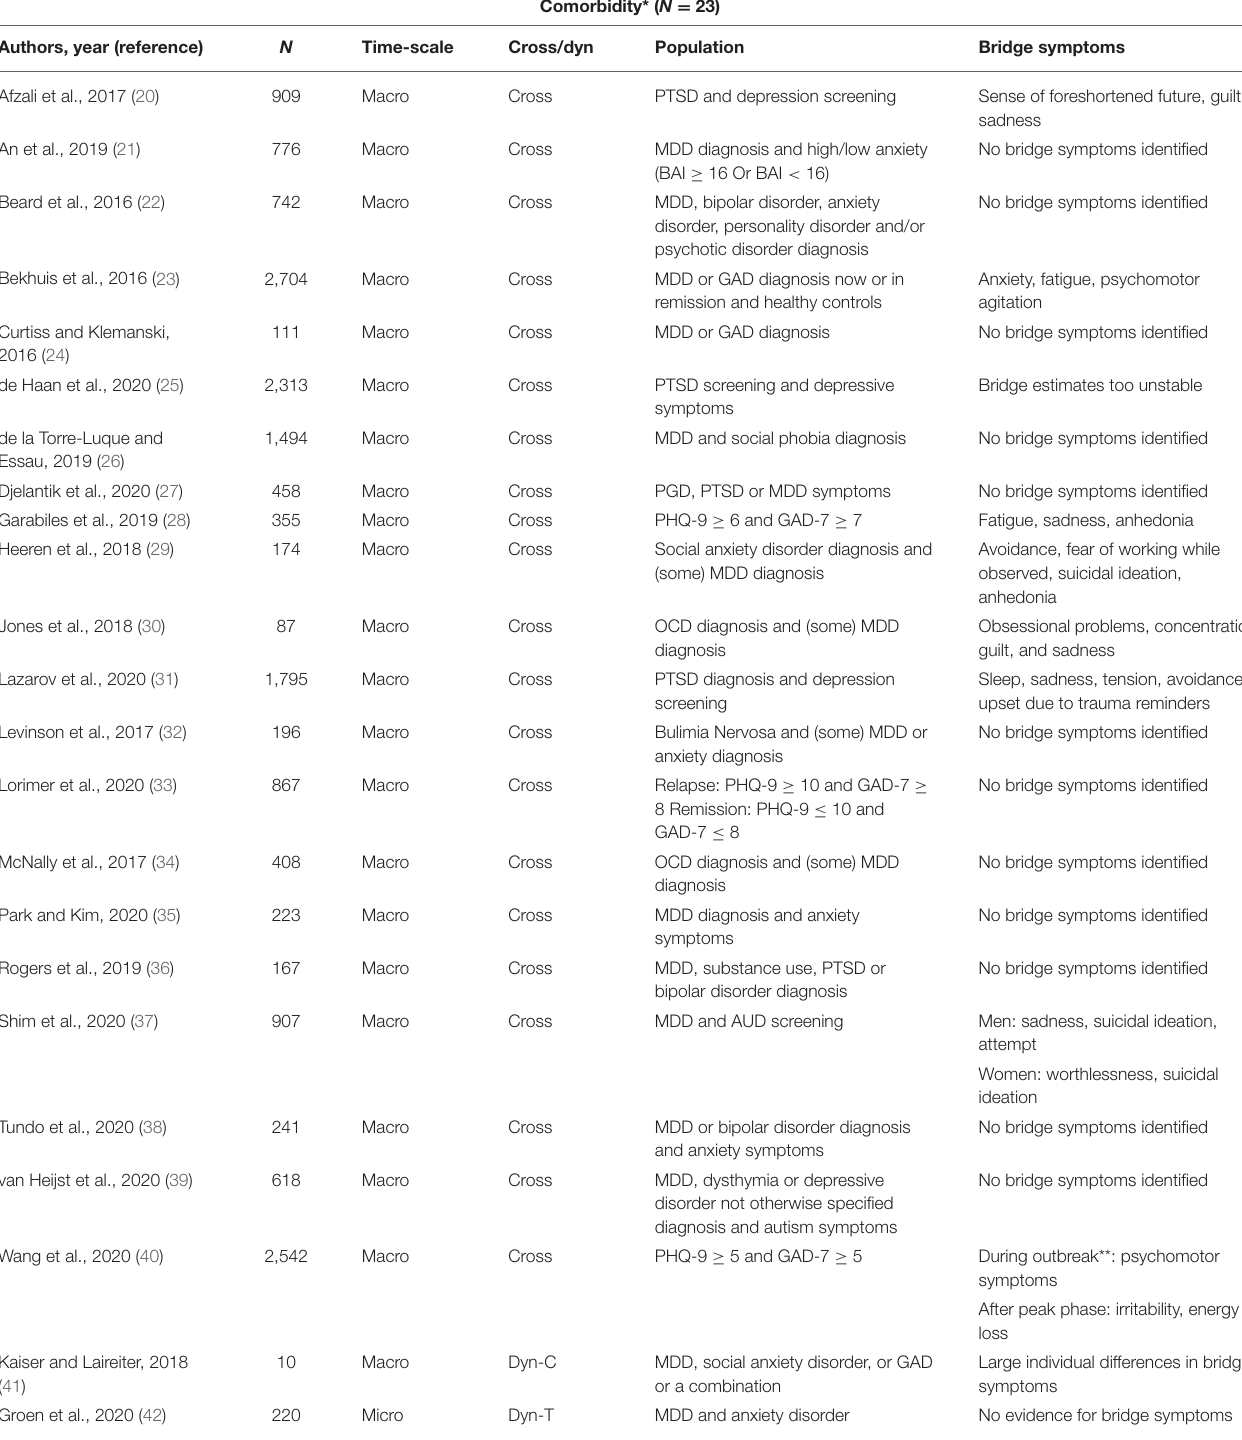
TABLE 1 | Overview of network studies on depression ( N =